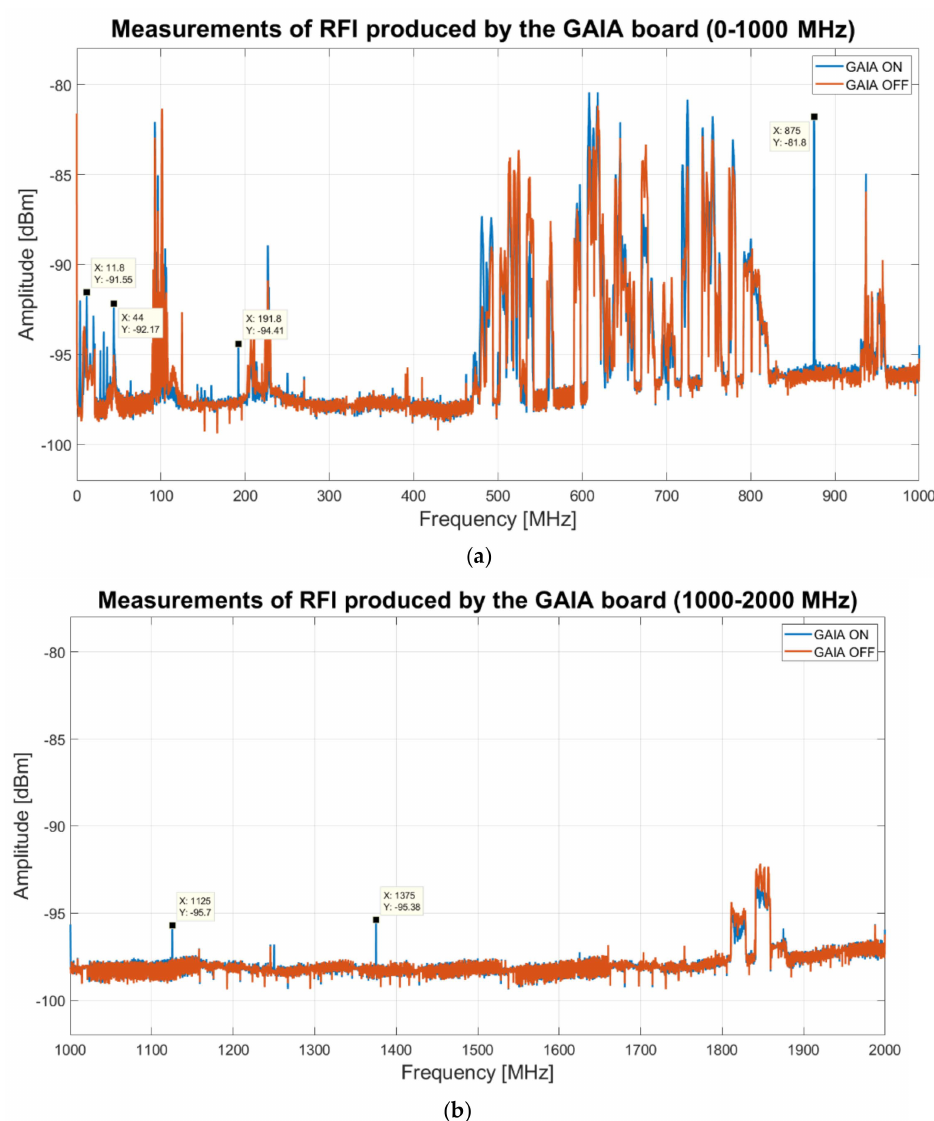
Figure 11. Results of the measurement campaign for surveying the signals generated by the GAIA electronic board [53]: ( a ) frequency range between 0 and 1 GHz [53]; ( b ) frequency range between 1 and 2 GHz